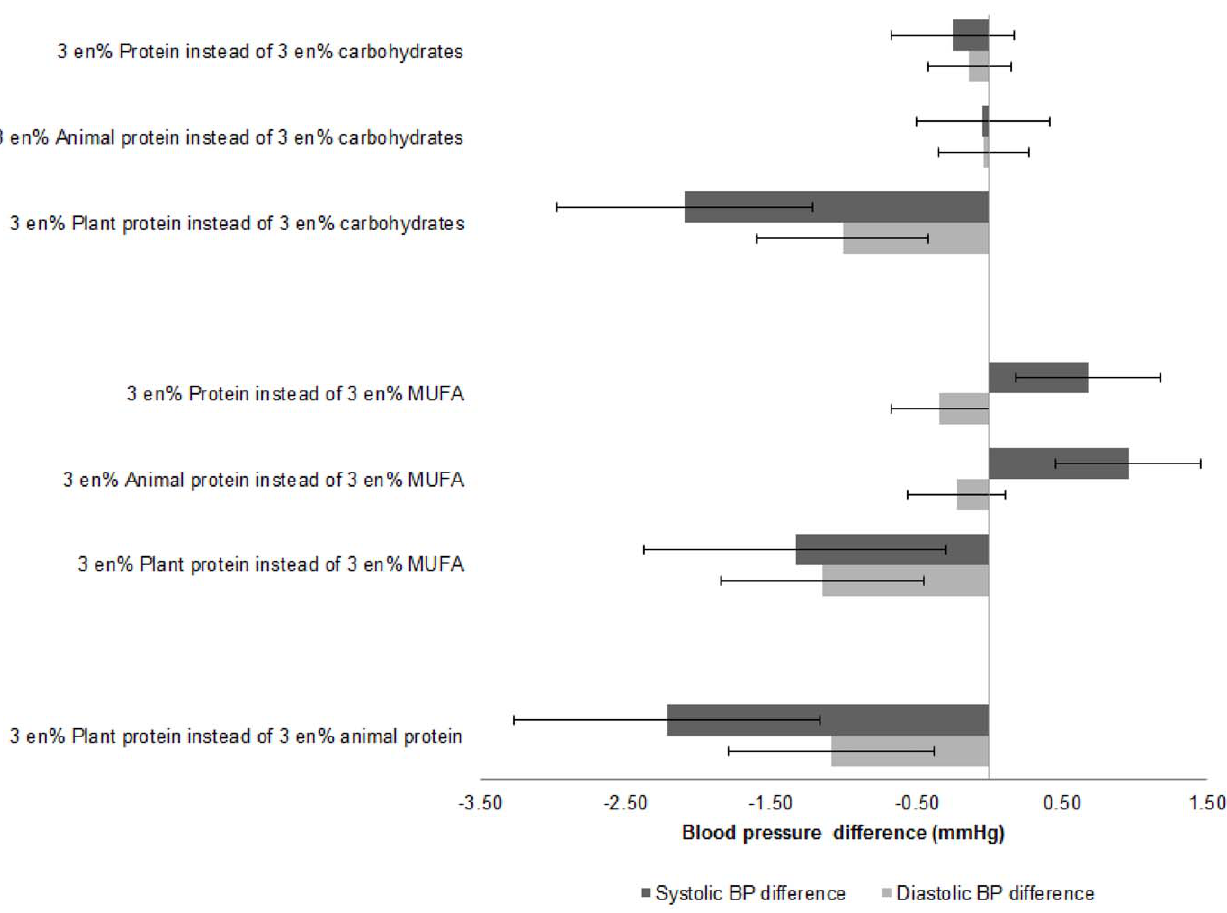
Figure 1. Fully adjusted systolic BP difference (mmHg) associated with replacement of 3 en% of carbohydrates or fat by total, plant or animal protein and by replacement of animal protein by plant protein.